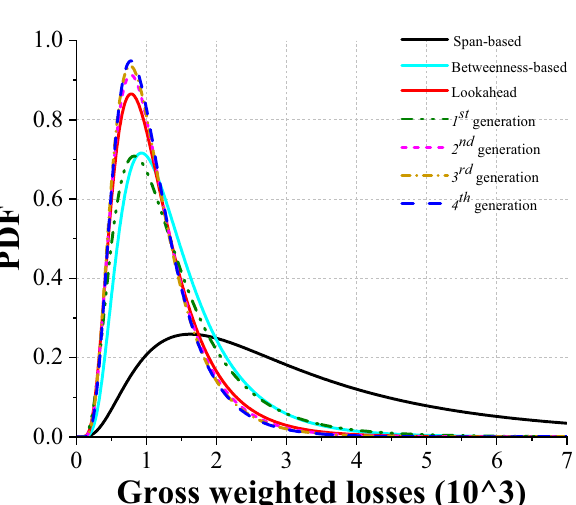
Table 1. Performance of rapid responses guided by different strategies.